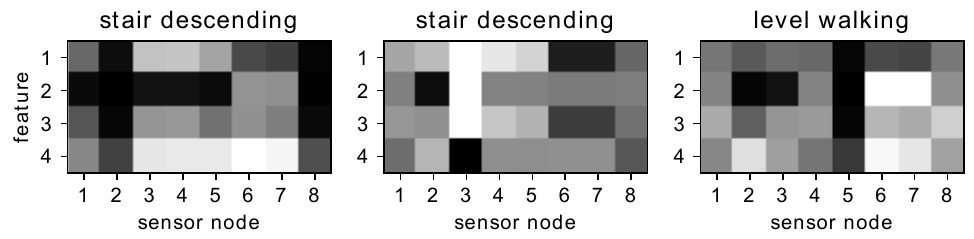
Figure 4. Maps of features calculated from different sensor nodes in a step.